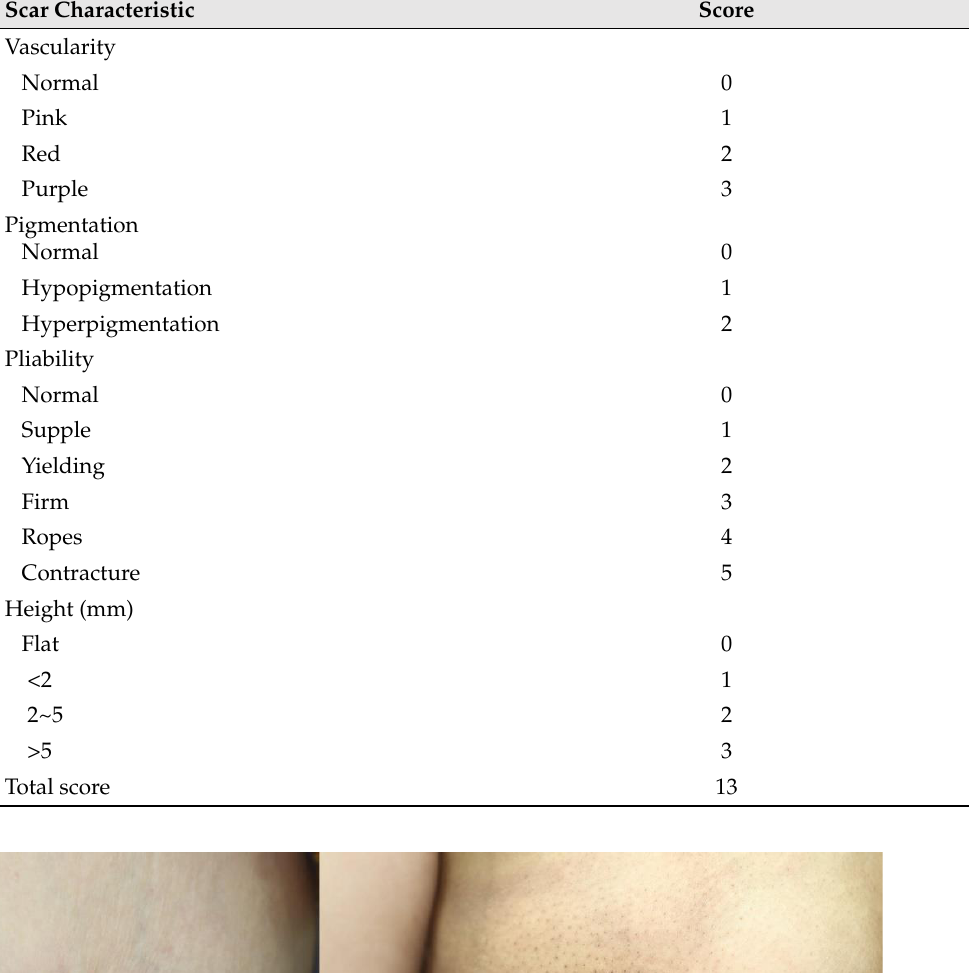
Table 1. The Vancouver Scar Scale (VSS).